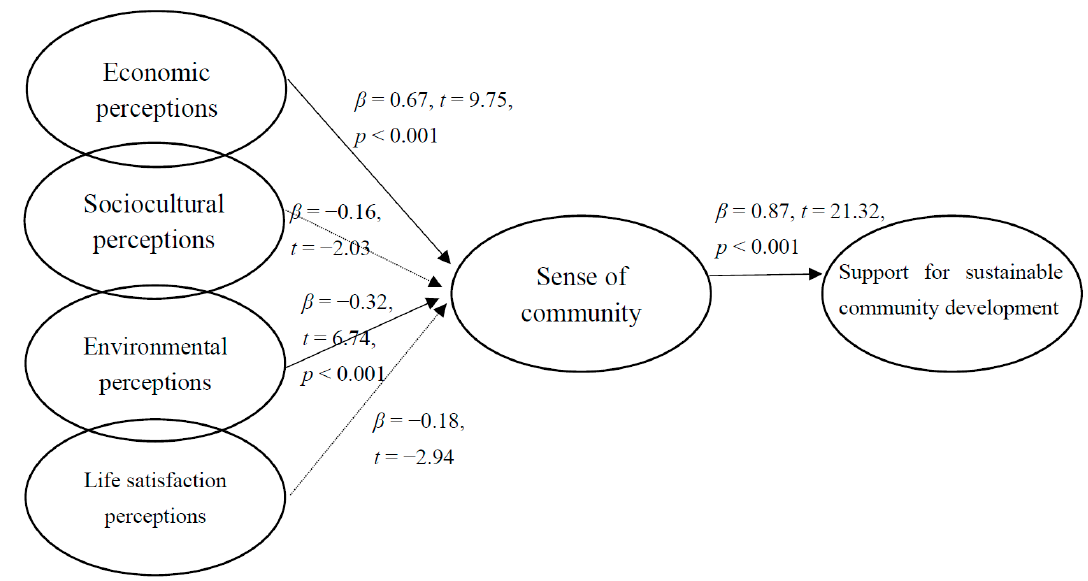
Figure 3. Structural model for New Laiyi.